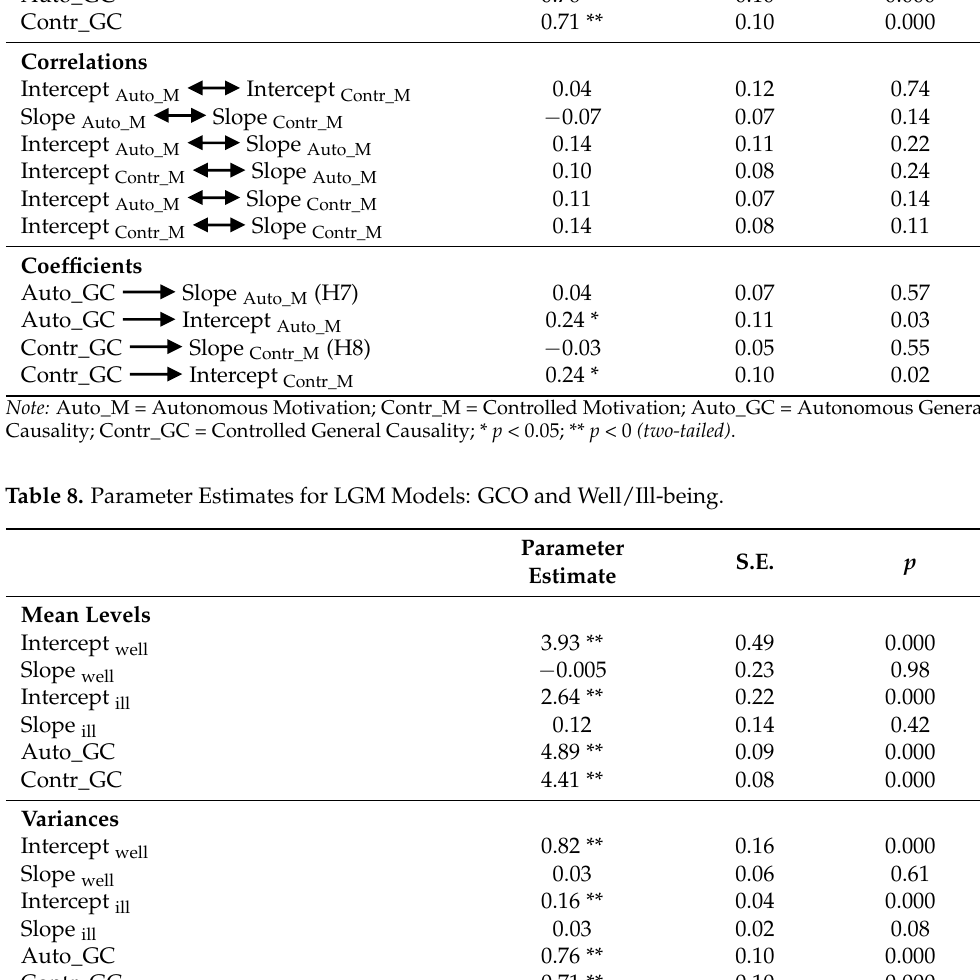
grated research model.